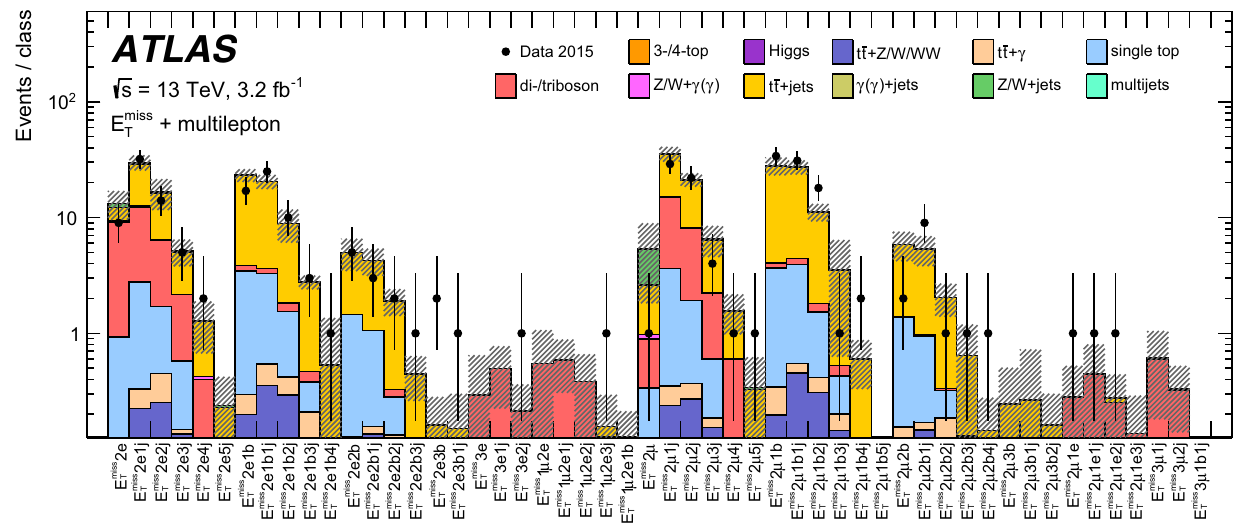
Fig. 22 The number of events in data, and for the different SM back- ground predictions considered, for classes with large E miss pair of same flavour leptons and ( b -)jets (no photons). The classes are